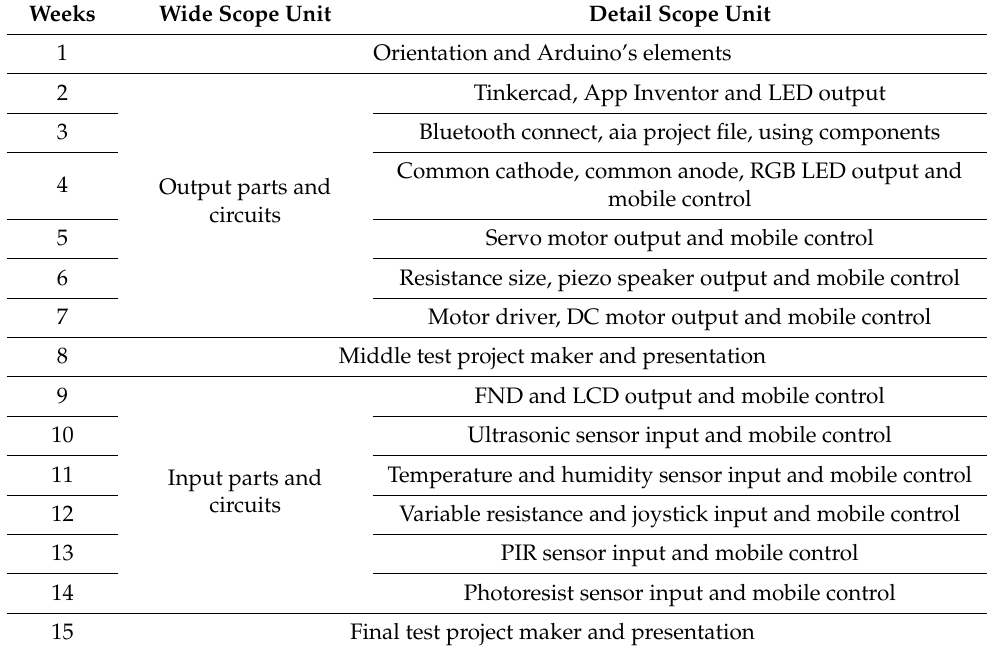
Table 2. Question items for the mobile application usability